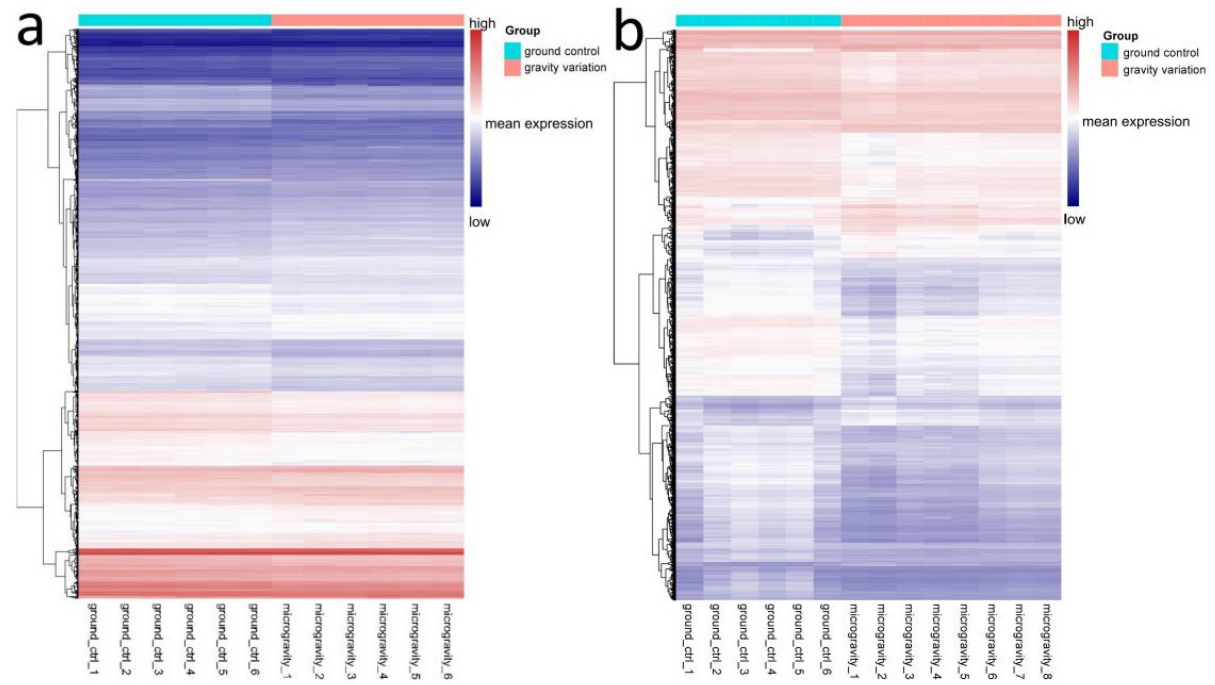
Figure 3. Heatmap for gene expression microarray of U937 cells and Jurkat T cells. Differential expression analysis was performed on Jurkat T cells ( a ) and U937 cells ( b ) samples, which were divided into gravity change group and ground control group. In the gravity variation group, U937 cells and Jurkat T cells underwent a 40 s gravity change flight, including a 20 s high-gravity lift-off and immediately followed by a 20 s microgravity parabolic flight. 6095 and 2970 differentially expressed genes were obtained in U937 and Jurkat T, respectively. Genes in the two groups of cells were expressed differently in microgravity conditions. Each line of the heat map represents a gene. The text below is the sample number, each column of the heat map represents a sample. The left tree structure represents a similar settlement relationship between samples. In the picture, white represents the mean expression of the sample, red represents the genes with high expression levels and blue represents the genes with low expression levels.